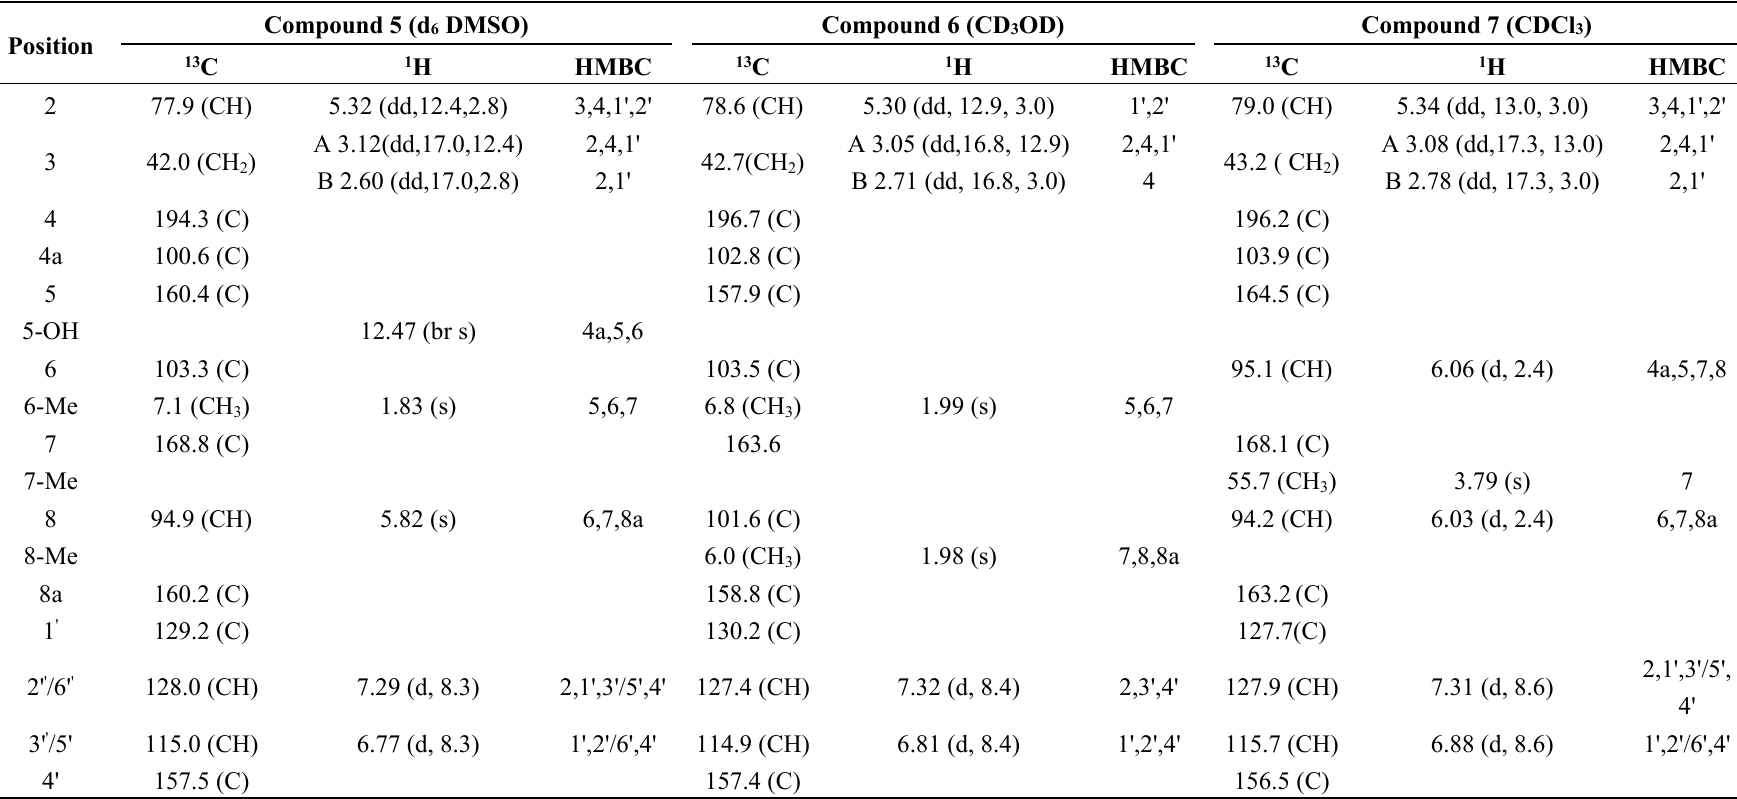
Table 3. 1 H and 13 C-NMR spectral data for compounds 5 – 7 from Corymbia